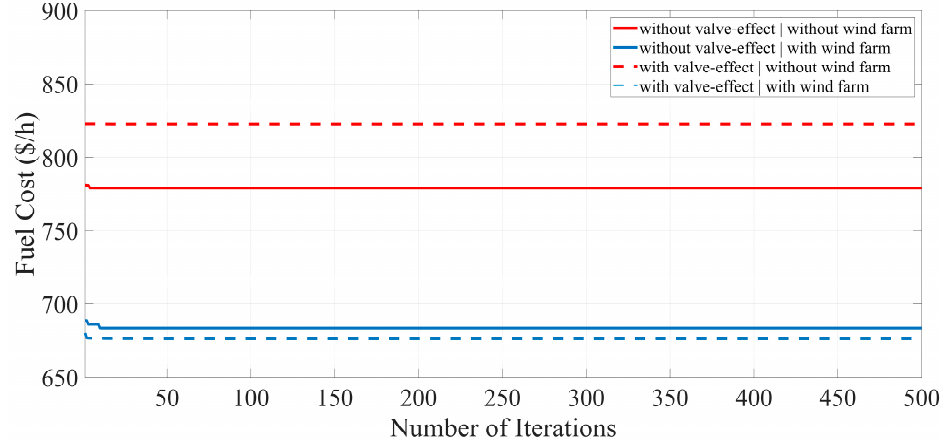
Figure 4. The convergence curves for the fuel cost minimization considering and neglecting the valve-point effect for the Test System 1. Electronics 2020 , 9 , x FOR PEER REVIEW